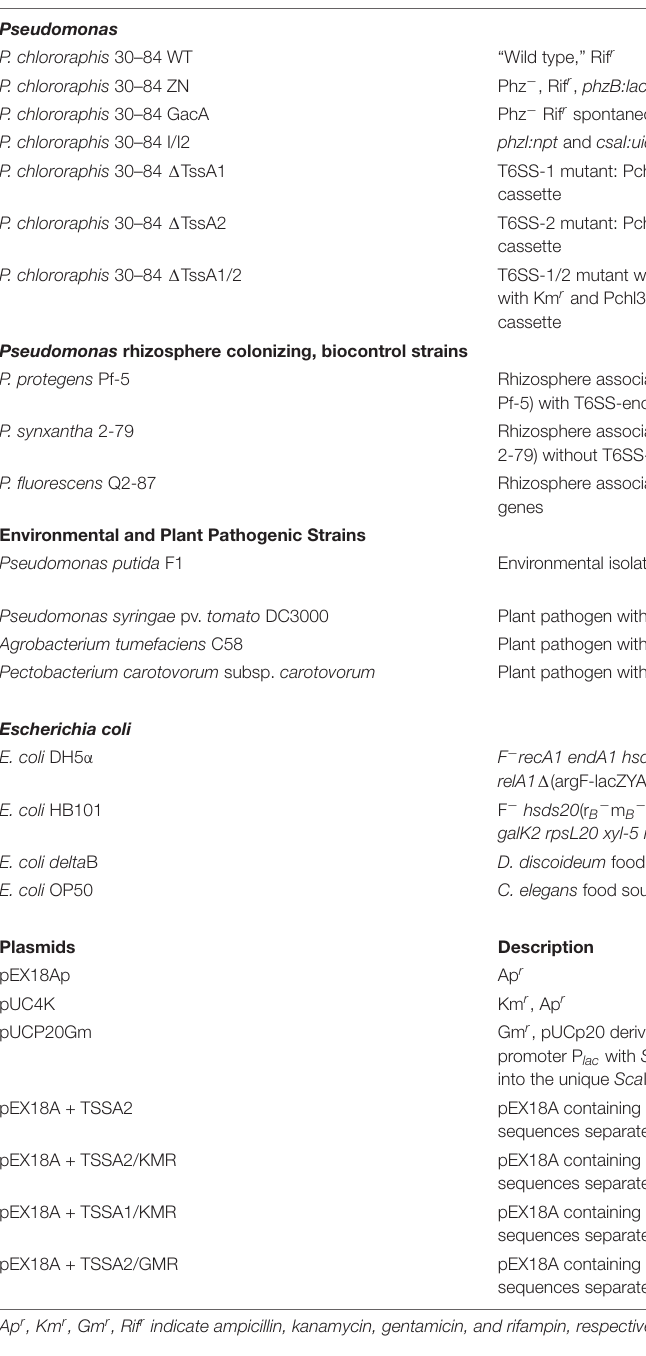
Table S1 ). The kanamycin resistance cassette with its